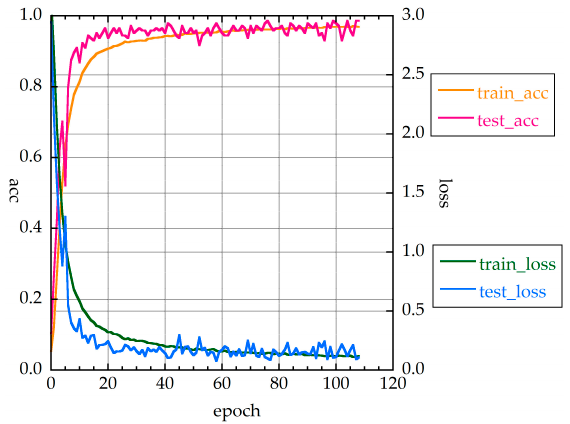
Figure 13. Accuracies and loss function values of MLP_M_HQ.